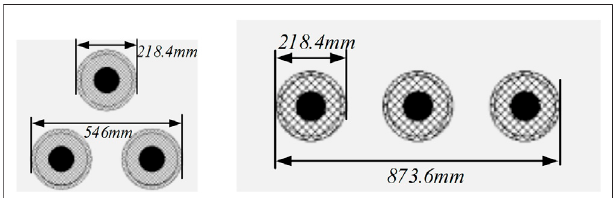
FIGURE 5 | Different arrangements of single-core